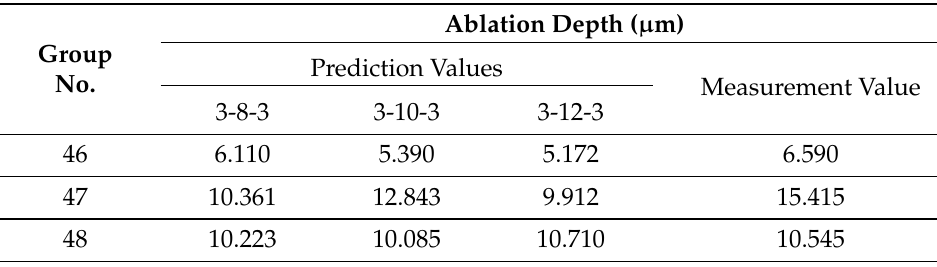
Table 8. Prediction results of testing set data.